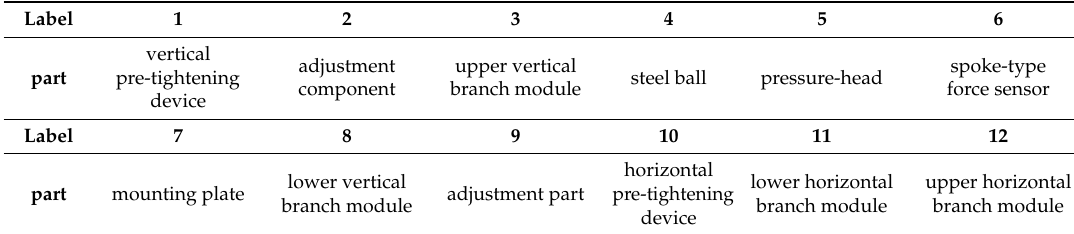
Table 2. The specifications of the major parts of the sensor.